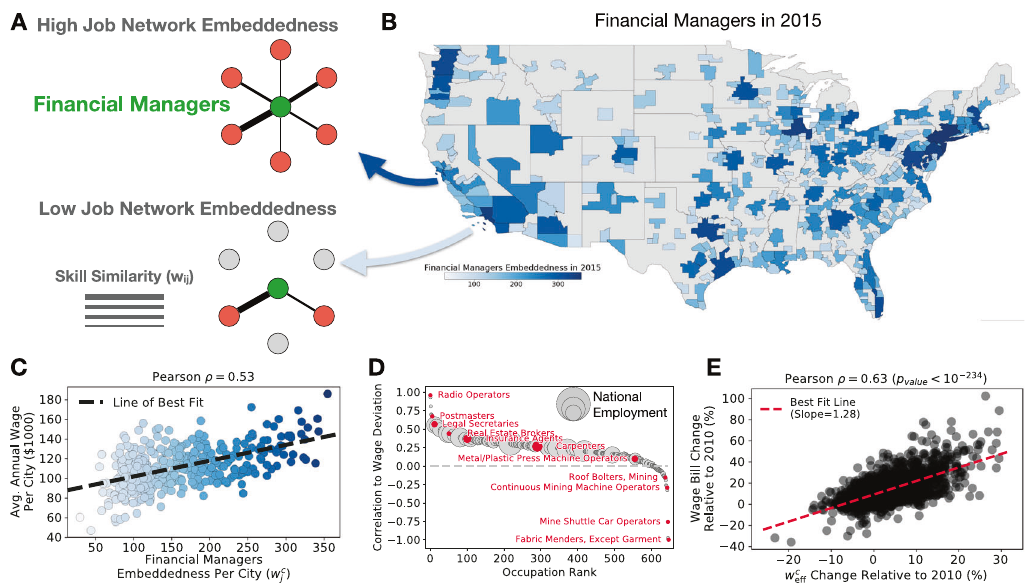
Fig. 3 Workers earn higher wages when their occupation is embedded in their local labor market which increases job connectivity and the city ’ s wage ) in a city ’ s job network projection. B US cities colored according to the embeddedness of bill. A A schematic explaining occupation embeddedness ( w c j Financial Managers in 2015. C In cities where the occupation is more embedded, Financial Managers earn higher wages than their peers in other cities. Point color corresponds to Financial Manager ’ s embeddedness in each city (i.e., corresponds to the city ’ s color in B )). D For 75% of workers nationwide, workers of the same occupation earn higher wages in cities where the occupation has greater embeddedness. See Supplementary Note 8 for a controlled regression analysis and embeddedness maps for other occupations. E Using 2010 as a baseline, cities that increased job connectivity ( w c ) saw eff corresponding increases in wage bill ($). There is a data point for each city and each year from 2011 to 2017. See Supplementary Note 9 for regression analysis and a similar analysis of year-to-year